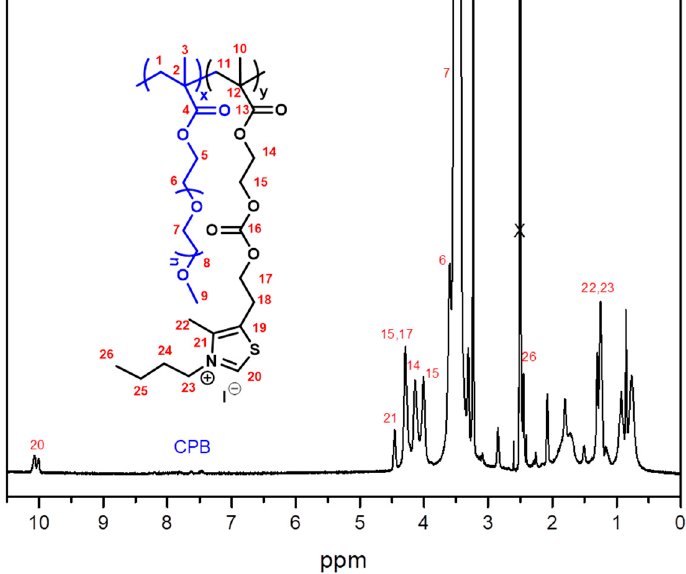
Figure 3. 1 H NMR spectrum of the copolymer quaternized with 1-iodobutane, P(PEGMA– co –MTZ-BuI), for a PEGMA/MTZ ratio of 50/50.